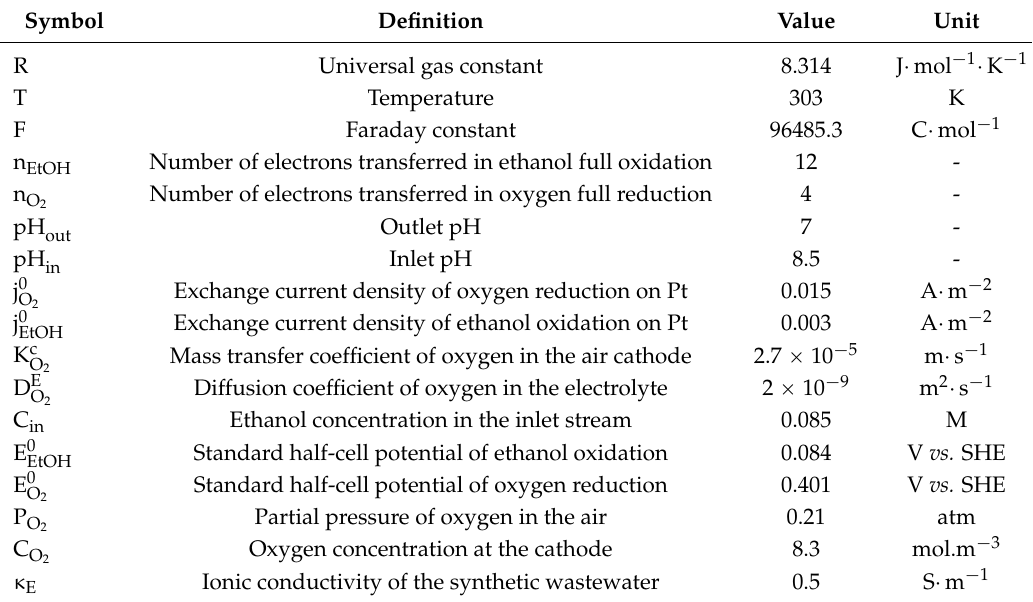
Table 5. Parameters of operation and the constants of the ethanol-air MFC